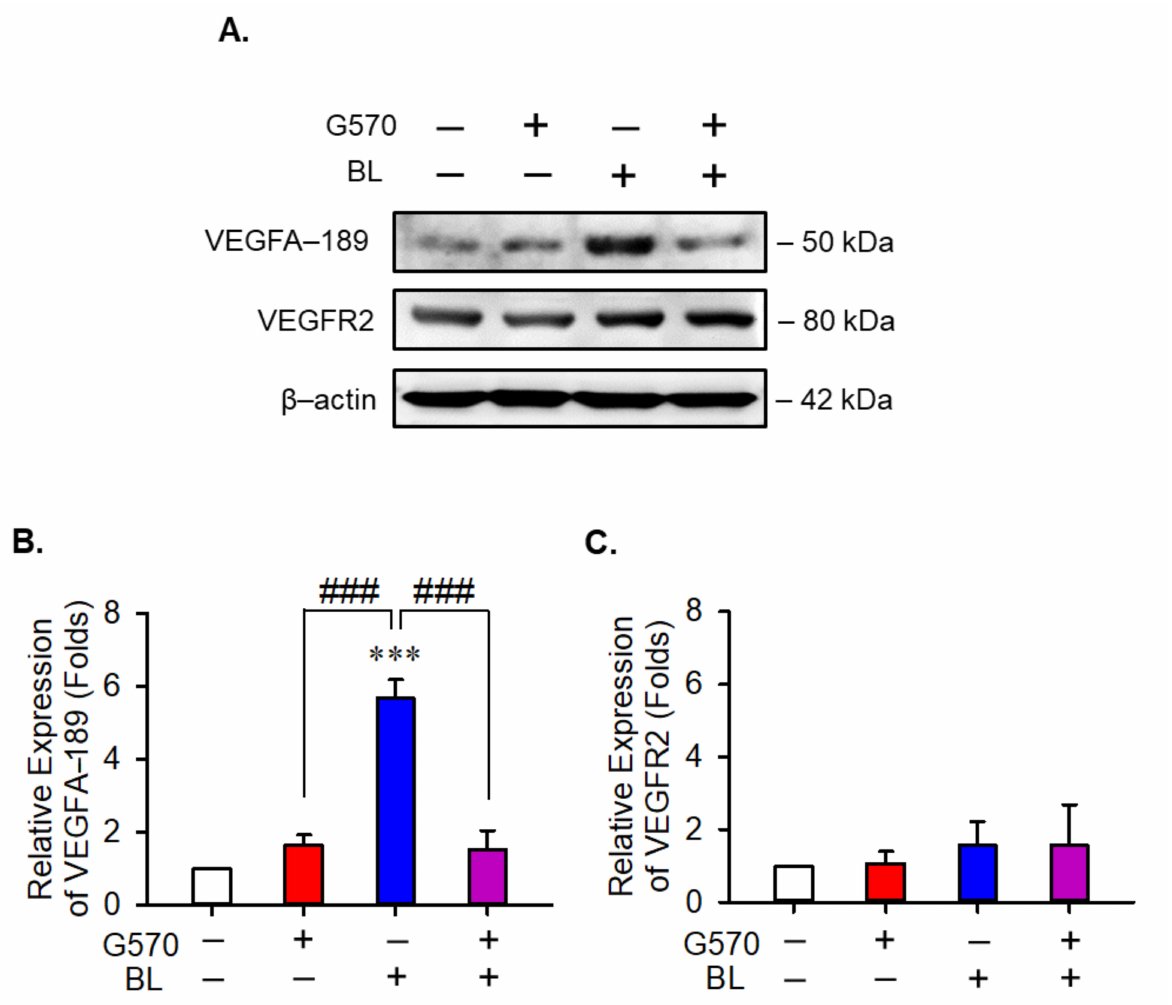
Figure 4. Expression of VEGFA-189 and VEGFR2 in BL-exposed ARPE-19 cells. The cells were seeded in a 6 cm dish. Each group was exposed to 150 lux BL and treated with 0.5 µ M G570. After 24 h, the cells were collected, and total protein was isolated for the western blot assay. ( A ) The expression levels of VEGFA-189 and VEGFR2 in ARPE-19 cells. ( B , C ) represent the densitometry of ( A ). Data are expressed as the mean ± S.D. and were obtained in triplicates. Significance was estimated compared to the control, where p *** ≤ 0.001 and p ### ≤